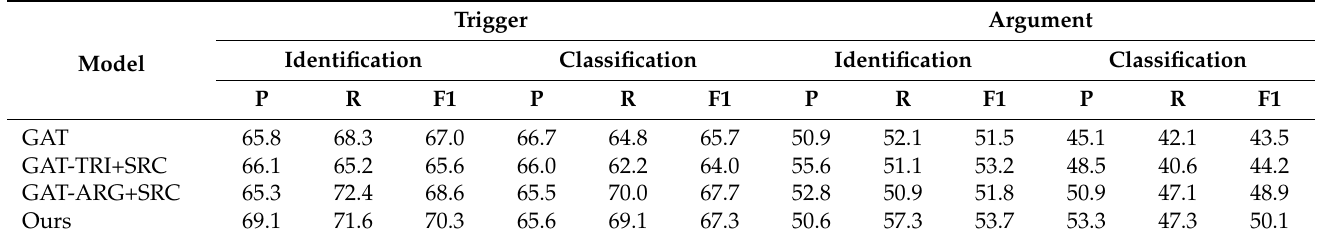
Table 4. Effect of